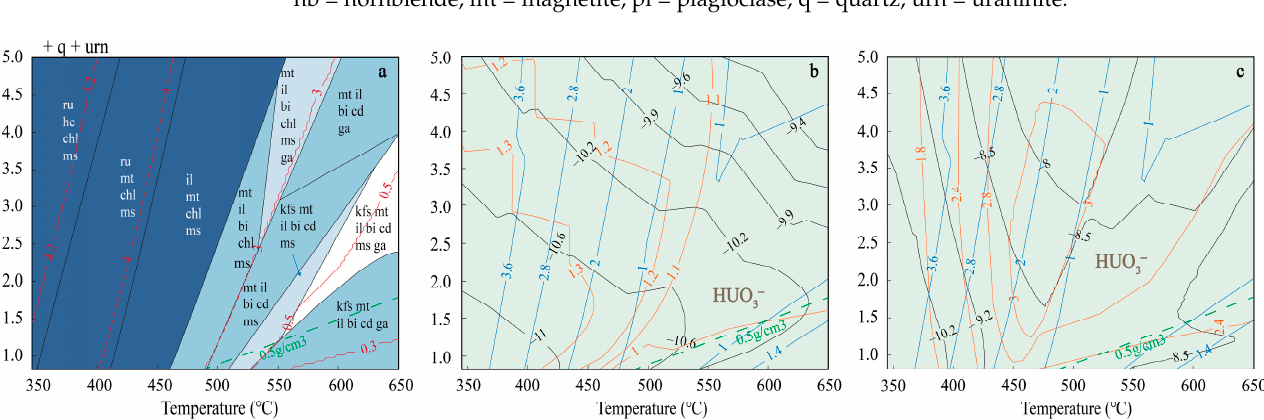
solubilities of uranium in pure water and 5 wt.% NaCl-H 2 O solution, respectively. The solubility of uranium is shown as logarithm of molality (black line), and the predominance fields of different uranium species are presented by different colors. The orange lines in ( b , c ) denote different Δ pH, which is the deviation of fluid pH from neutral pH (pH n ) ( Δ pH = pH − pH n ). The blue lines in ( b , c ) denote Δ FMQ, which is the difference in log f O 2 (g) of the fluid relative to the fayalite-magnetite- simulation are given in Table 1. Mineral abbreviations: act = actinolite; alb = albite; chl = chlorite; ep = epidote; hb = hornblende; mt = magnetite; pl = plagioclase; q = quartz; urn = uraninite.